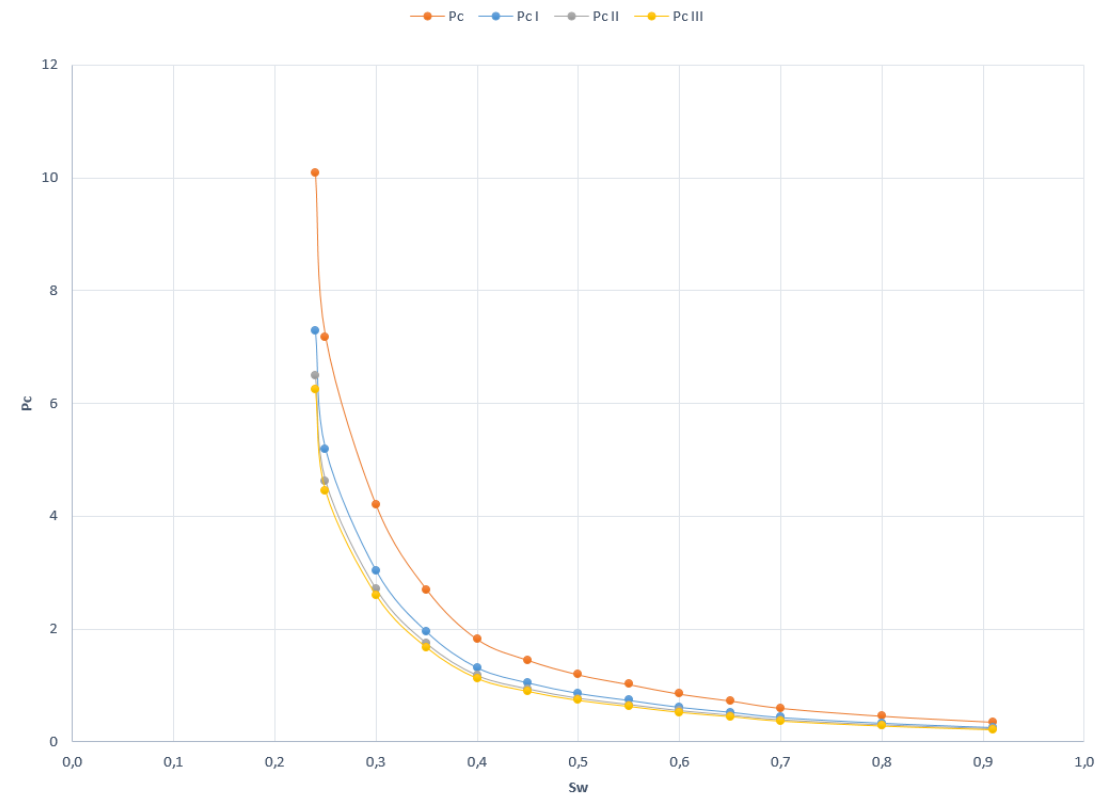
Figure 5. Changes in capillary pressure.